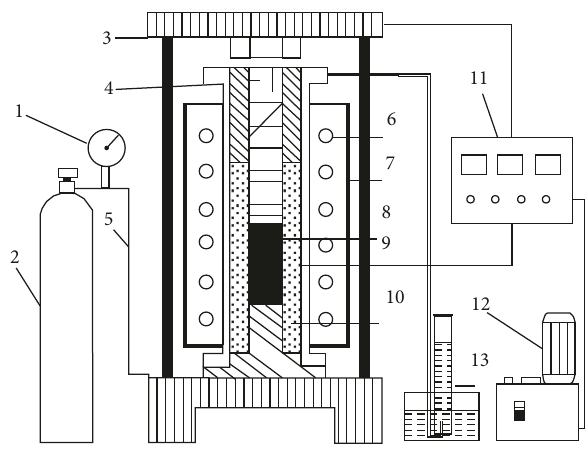
Figure 2: Schematic diagram of high-temperature triaxial per- meability testing system: (1) pressure gauge, (2) nitrogen tank, (3) support frame, (4) steel tube, (5) valve, (6) heating wire, (7) muff, (8) specimen, (9) thermocouple, (10) graphite packing, (11) tem- perature and pressure controller, (12) oil pump, and (13) measuring equipment of gas